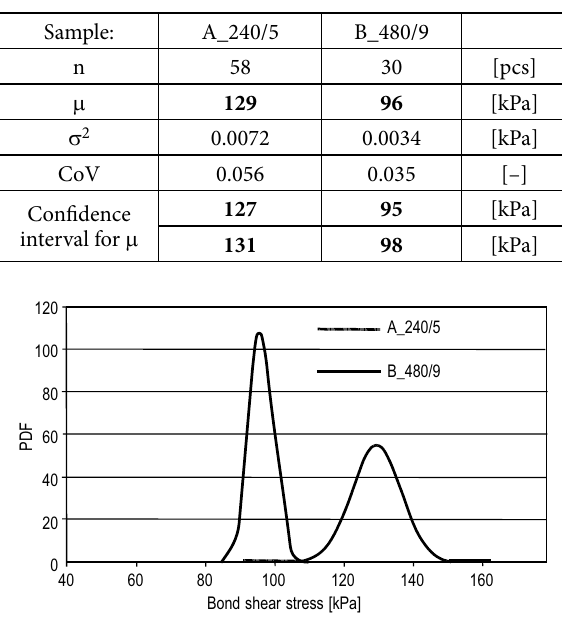
Fig. 5. Chart of PDF’s of Lognormal distribution of random variable τ